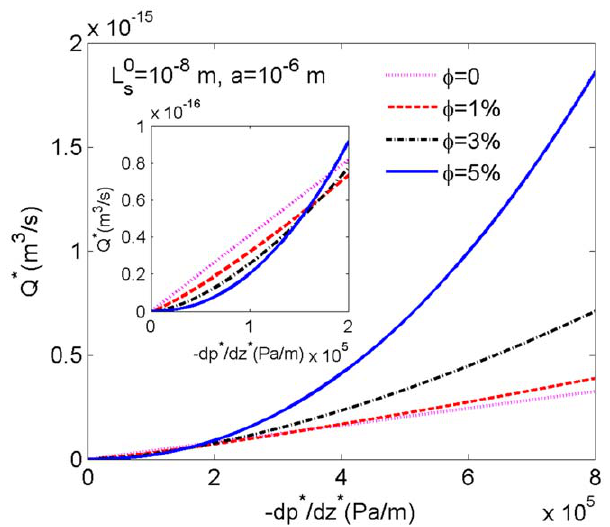
Figure 3. The volumetric flow rate of the nanofluid in a thin tube. We calculate the volumetric flow rates as a function of the pressure gradient for w ~ 0, 1%, 3% and 5% with radius a ~ 10 { 6 m and slip length L 0